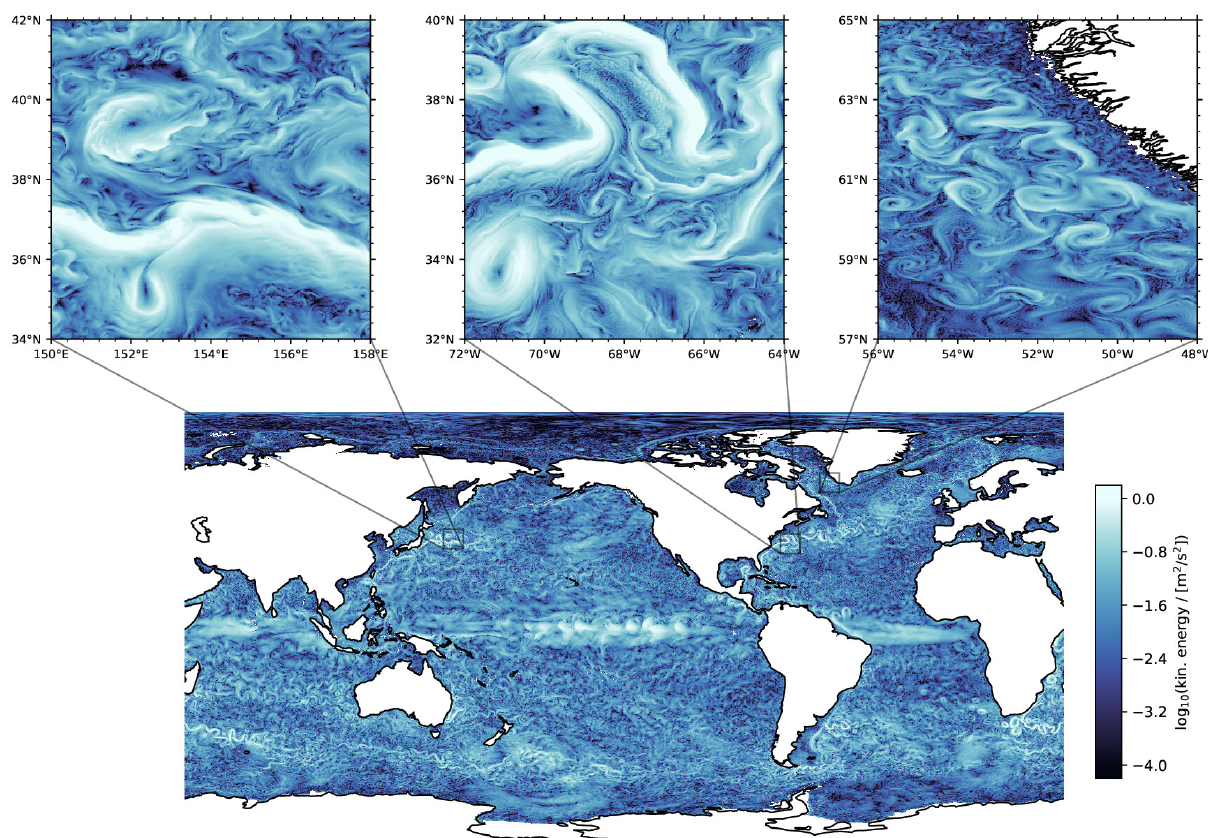
Figure 16. Snapshot of kinetic energy of G_O_1.25km with three additional zooms to highlight the richness of the dynamics that can be simulated at this